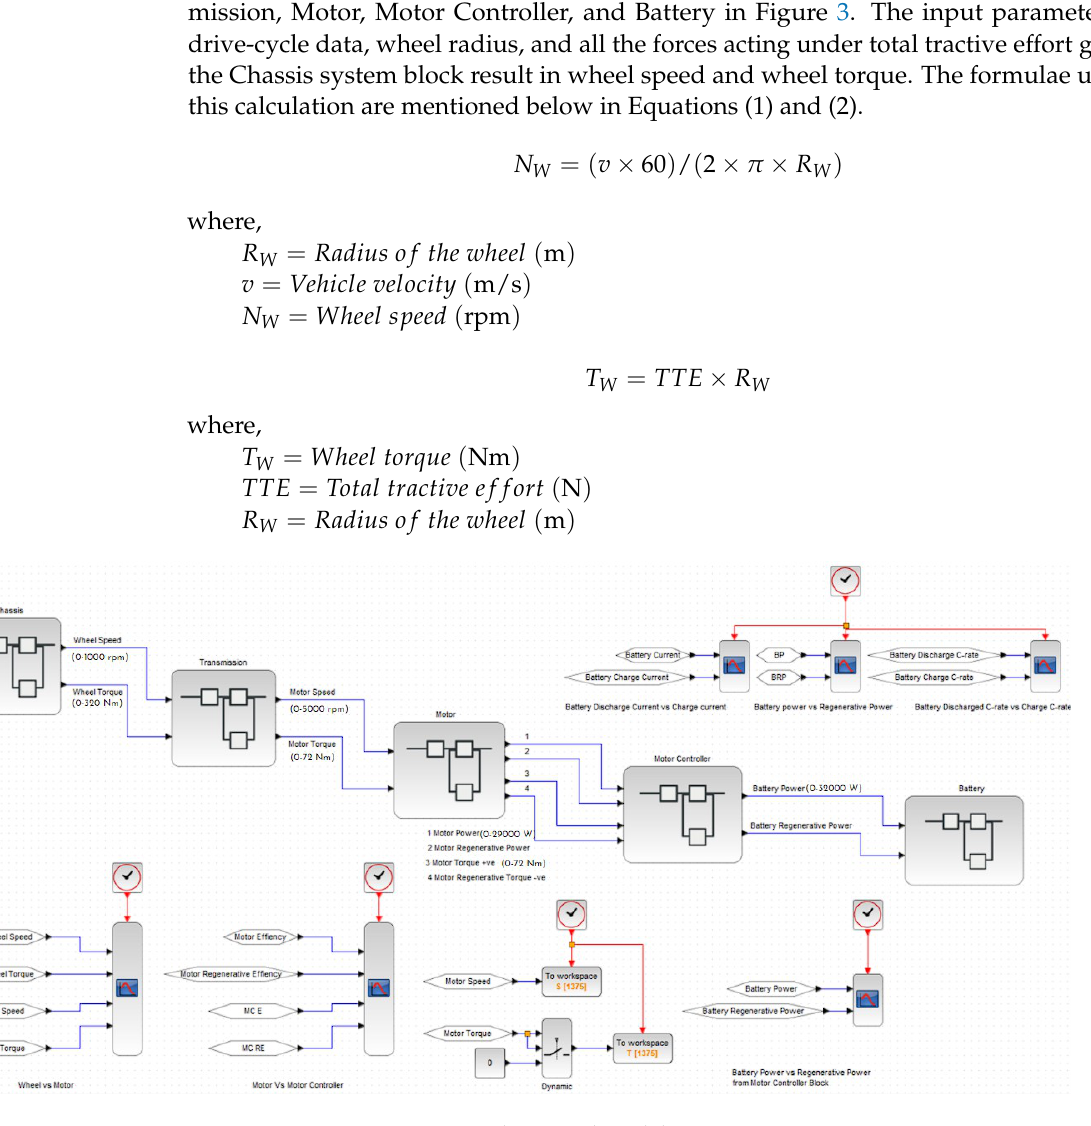
Figure 3. Powertrain sizing mathematical model.